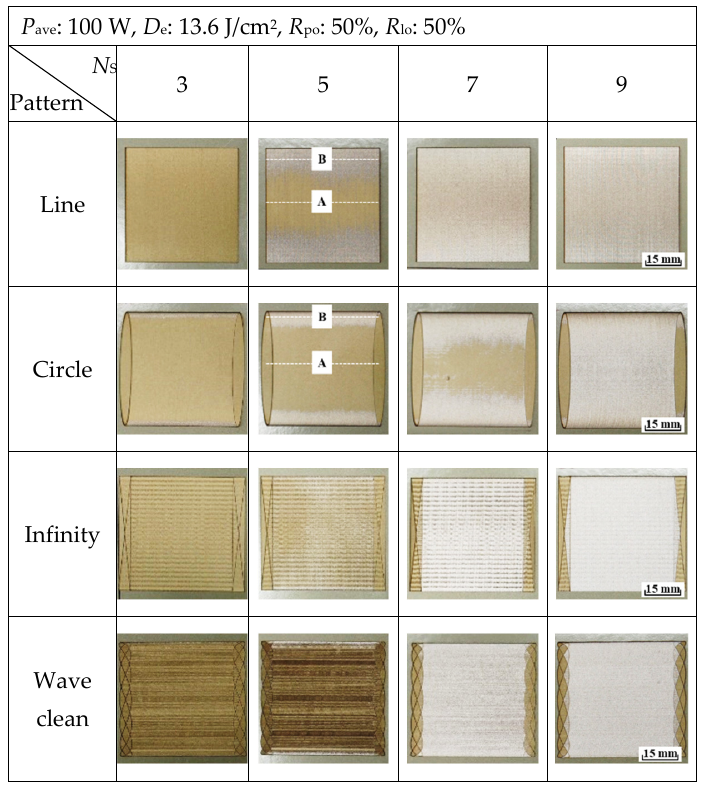
Figure 5. Laser-cleaned surfaces of epoxy-painted steel with the laser beam scanning patterns.